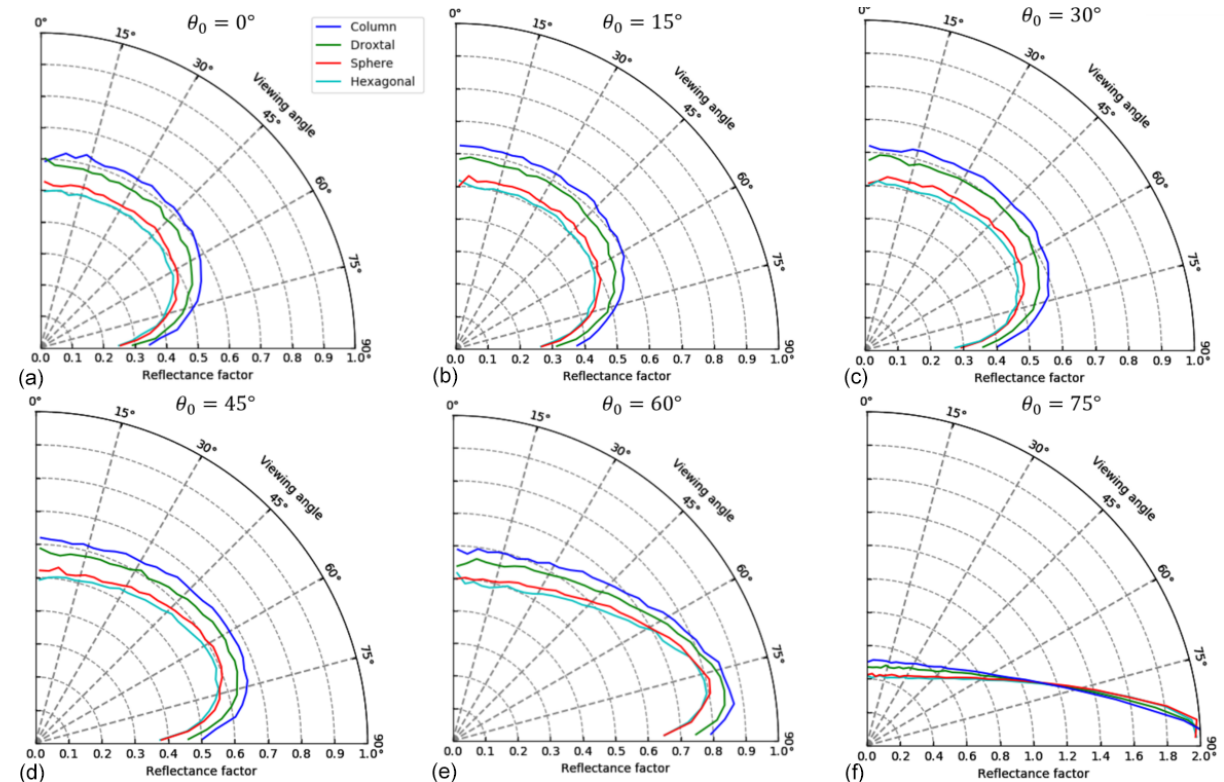
Figure 14. Same as Fig. 9 but for various ice particle shapes. The radial dimension for panel (f) is again extended to account for the high BRF